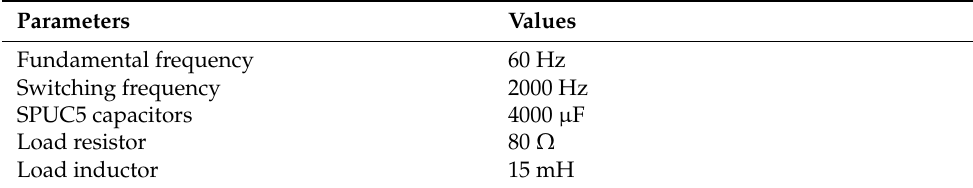
Table 3. Simulation parameters.